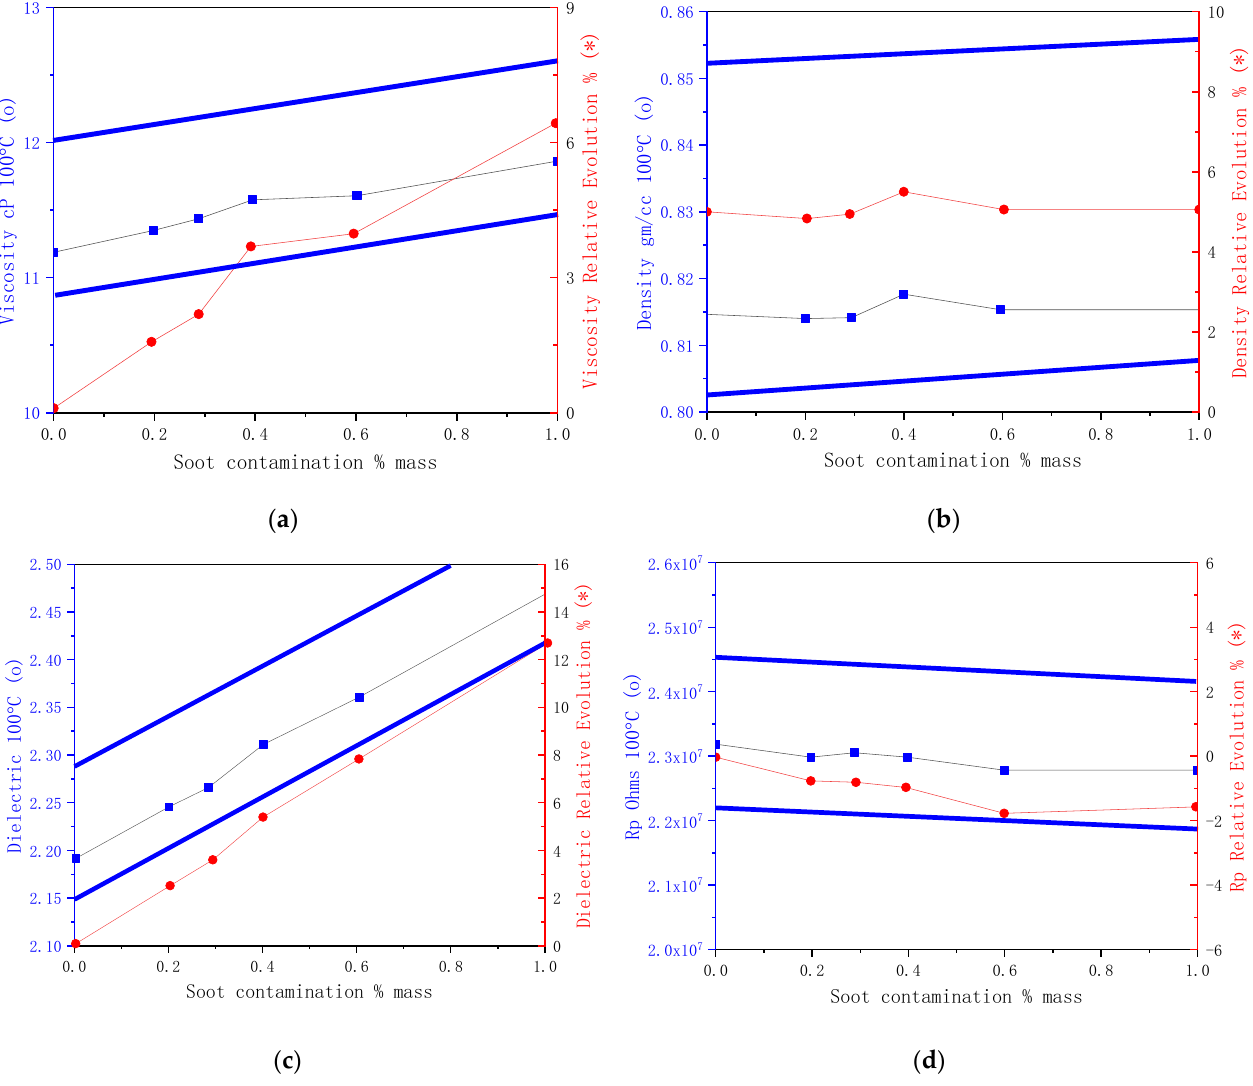
Figure 16. Soot contamination in engine oil (15W40) at 100 °C: ( a ) viscosity; ( b ) density; ( c ) dielectric; and ( d ) Rp.